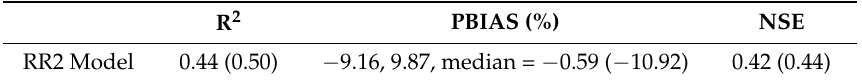
Figure 7. Histograms showing R 2 , PBIAS, and Nash–Sutcliffe model efficiency (NSE) of the “random verification” of Configuration 3. Table 9. RR2’s verification performance (daily, n = 857).